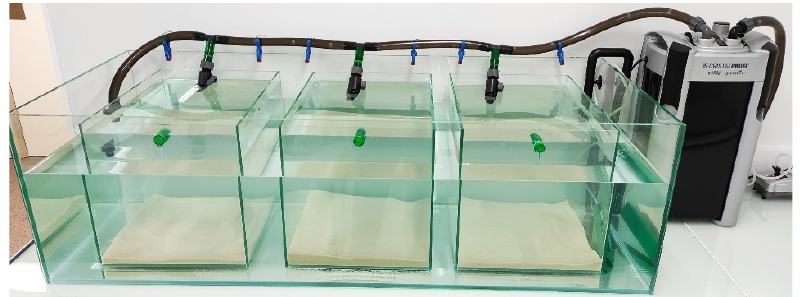
Figure 1. Large glass tank, containing 3 smaller replicate tanks. Each replicate tank was fi lled with a 2 cm layer of sediment and water, that was continuously oxygenated and mechanically fi ltered. Water level in the small tanks was maintained at a height of 28 cm, through an out fl ow into the main tank.